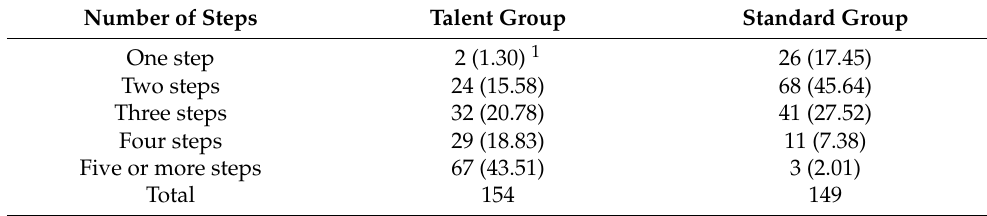
Table 2. Number of steps needed to solve the